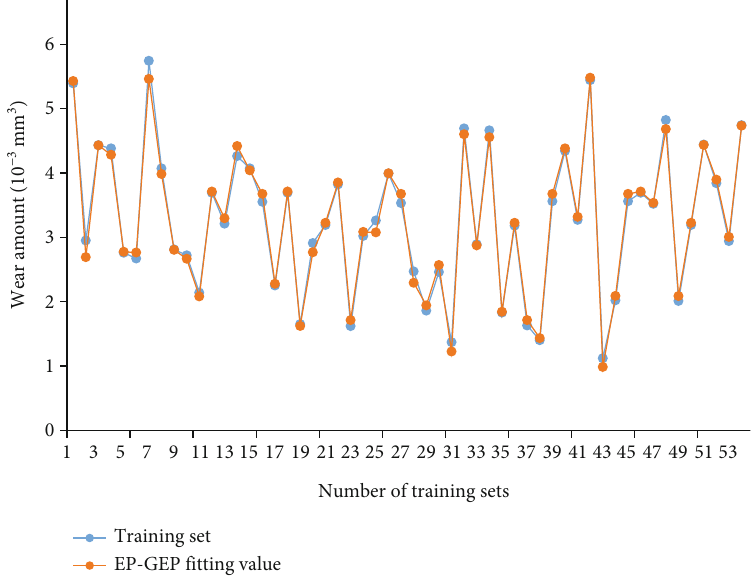
Figure 7: Comparison of training set wear and EP-GEP fi tting